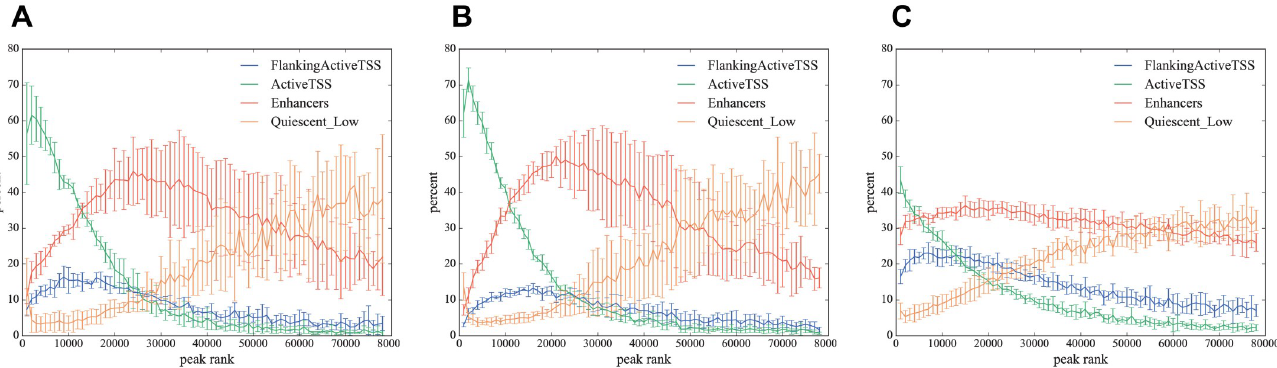
Fig 12. Functional annotations of peaks. Percentage ( 100 � j E y Only the functional annotations that have maximum percentages � 12%, y 2 {FlankingActiveTSS, ActiveTSS, Enhancers, Quiescent_Low}, are shown.